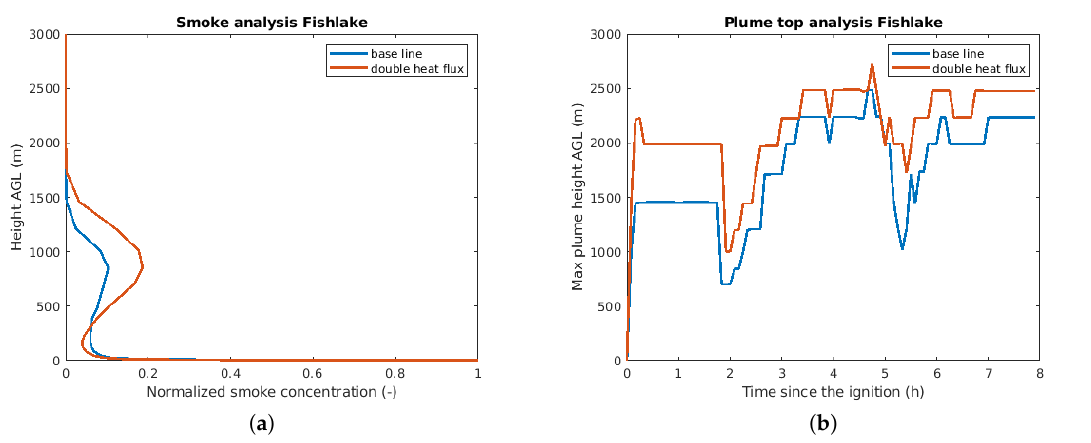
Figure 7. Smoke analysis for the Fishlake burn executed for 09/03/2014. ( a ) Vertical profile of normalized smoke concentration; ( b ) Time series of the plume top height.